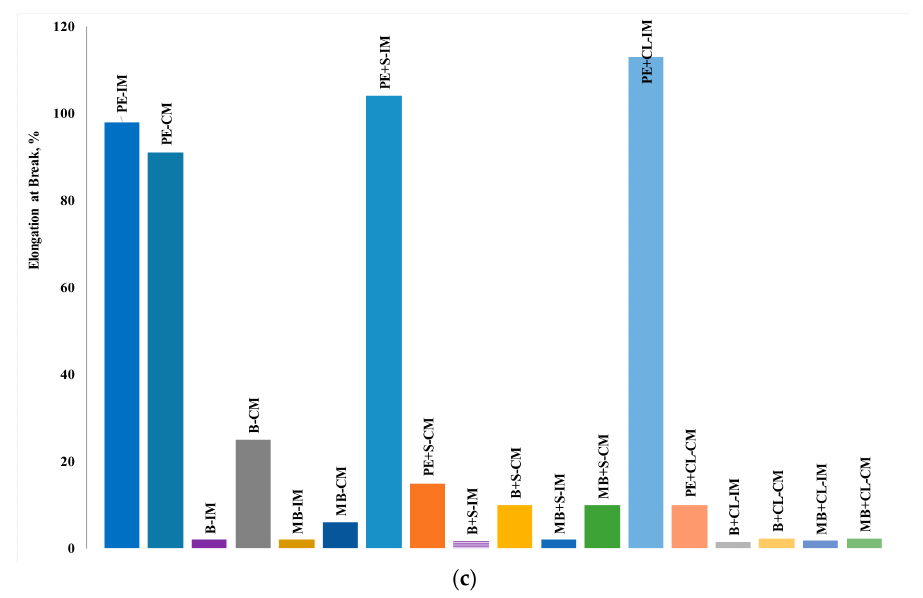
Figure 4. ( a ) Elastic modulus of compression-molded (CM) and injection-molded (IM) samples. ( b ) Tensile strength of compression-molded (CM) and injection-molded (IM) samples. ( c ) Elongation at break of compression-molded (CM) and injection-molded (IM) samples; (PE = HDPE, B = Bioflex, MB = MaterBi, S = calcium carbonate, CL = clay).